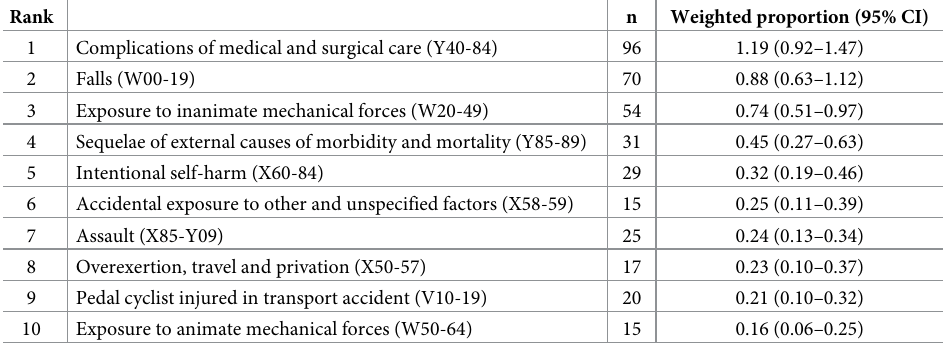
Table 1. Frequencies of accidents and injuries after phase 2 ordered by weighted proportion.